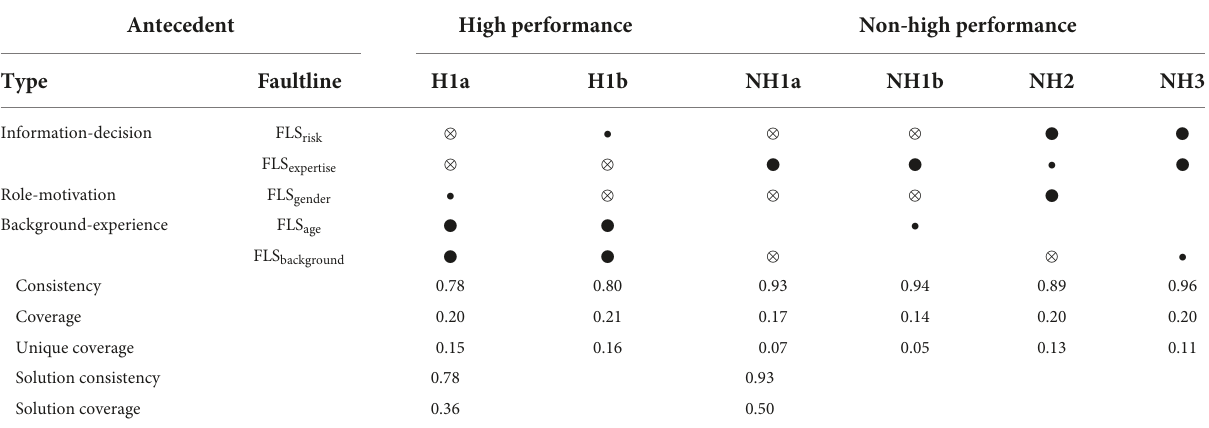
TABLE 6 Faultline